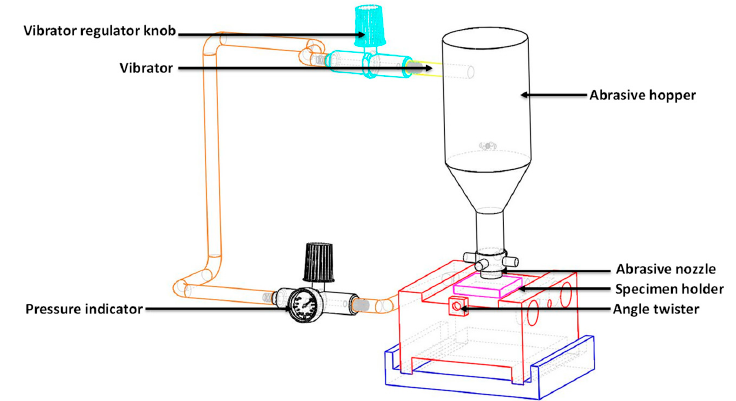
Figure 2. Schematic of the erosion machine used to study the erosive wear behavior of API X120 steel [25].